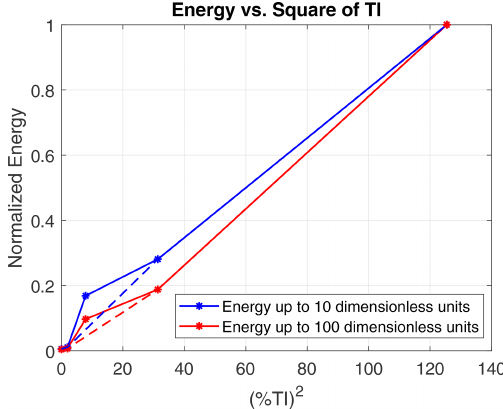
Figure 11. Energy at 10% chord up to 10 and 100 dimensionless frequency units against the square of the turbulence intensity. The energy is normalized by the value at a TI of